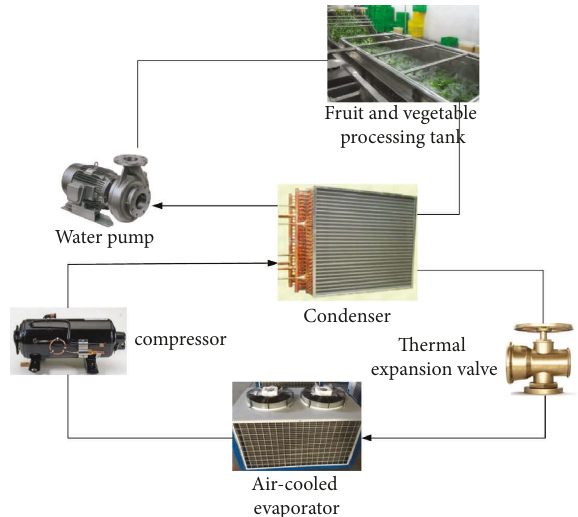
Figure 1: Schematic diagram of the heat treatment system for fruits and